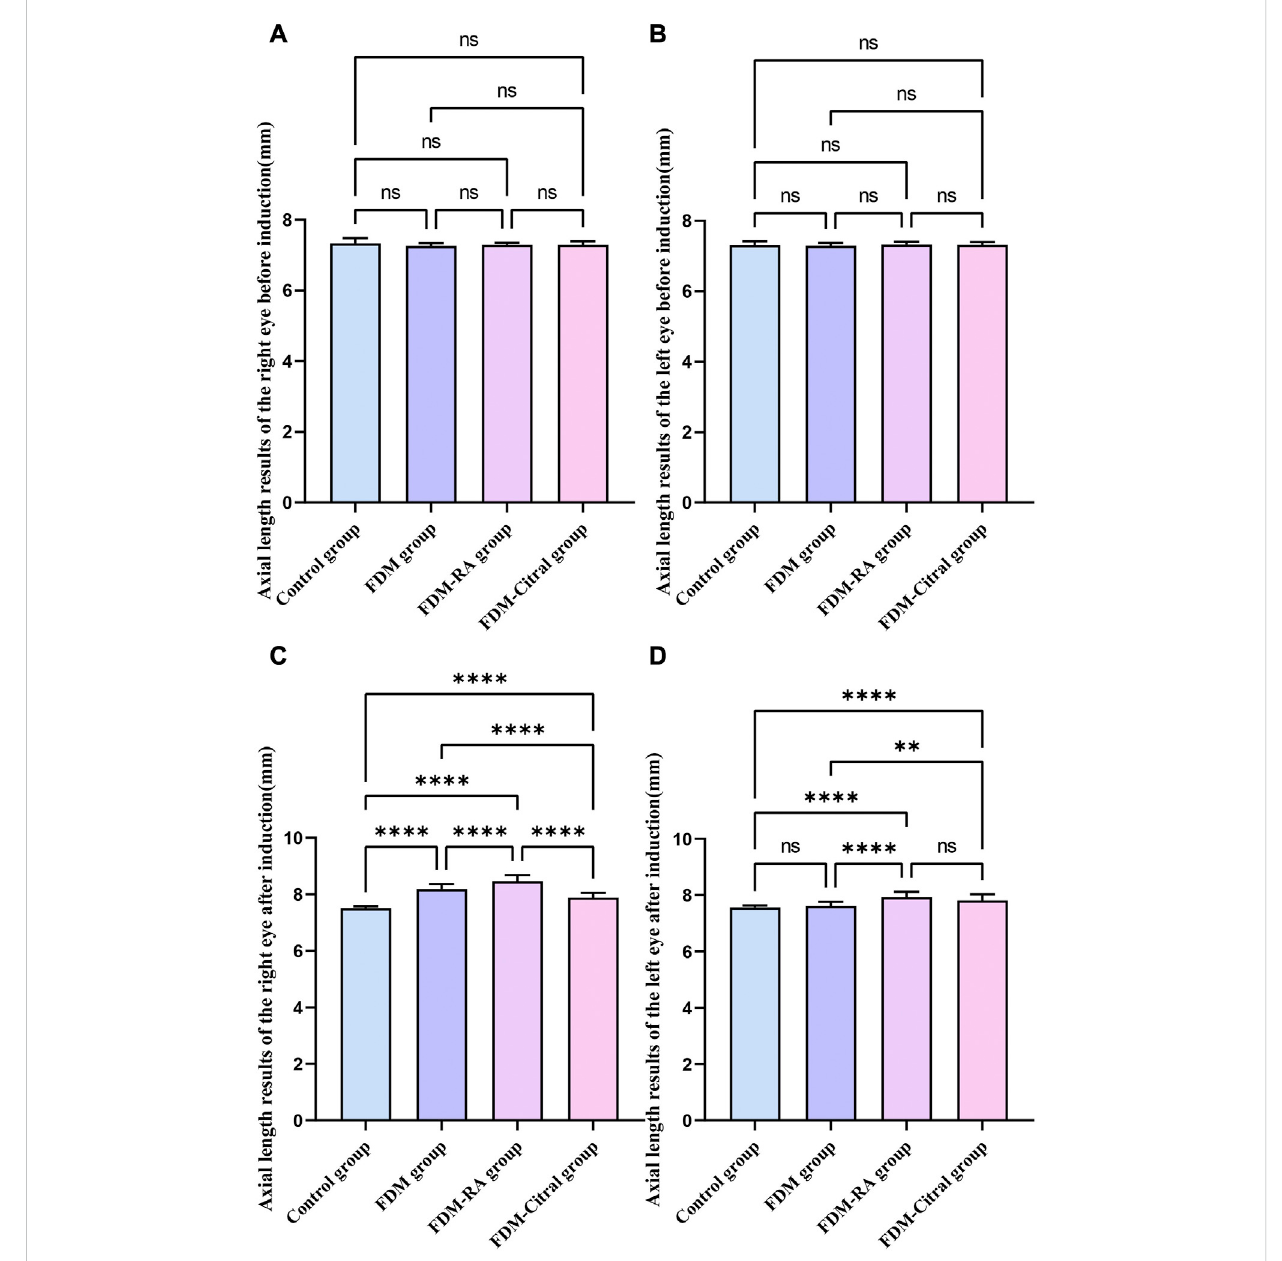
FIGURE 4 Comparison ofAL results offourgroups ofguinea pigs(mm). Note. (A) ,ComparisonofAL intherighteye before induction; (B) ,ComparisonofAL in the left eye before induction; (C) , Comparison of AL in the right eye after induction; (D) , Comparison of AL in the left eye after induction; (D) , diopter; ns means that the difference is not statistically signi fi cant; *Indicates p ≤ 0.05; ** Indicates p ≤ 0.01; *** Indicates p ≤ 0.001; **** Indicates p ≤ 0.0001.